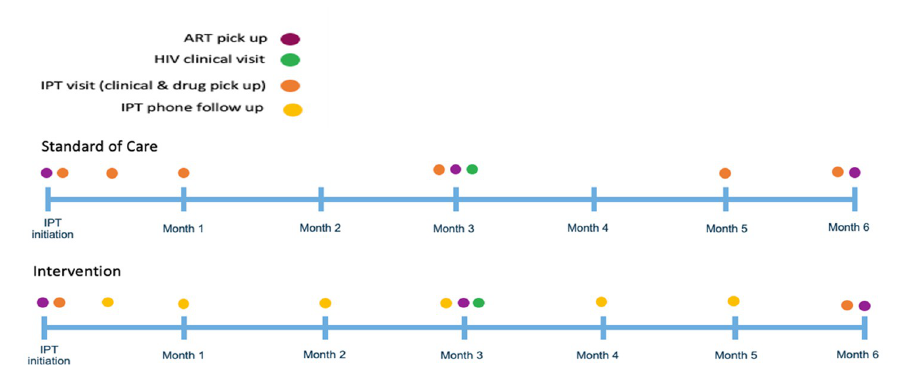
Fig 3. Intervention vs. standard of